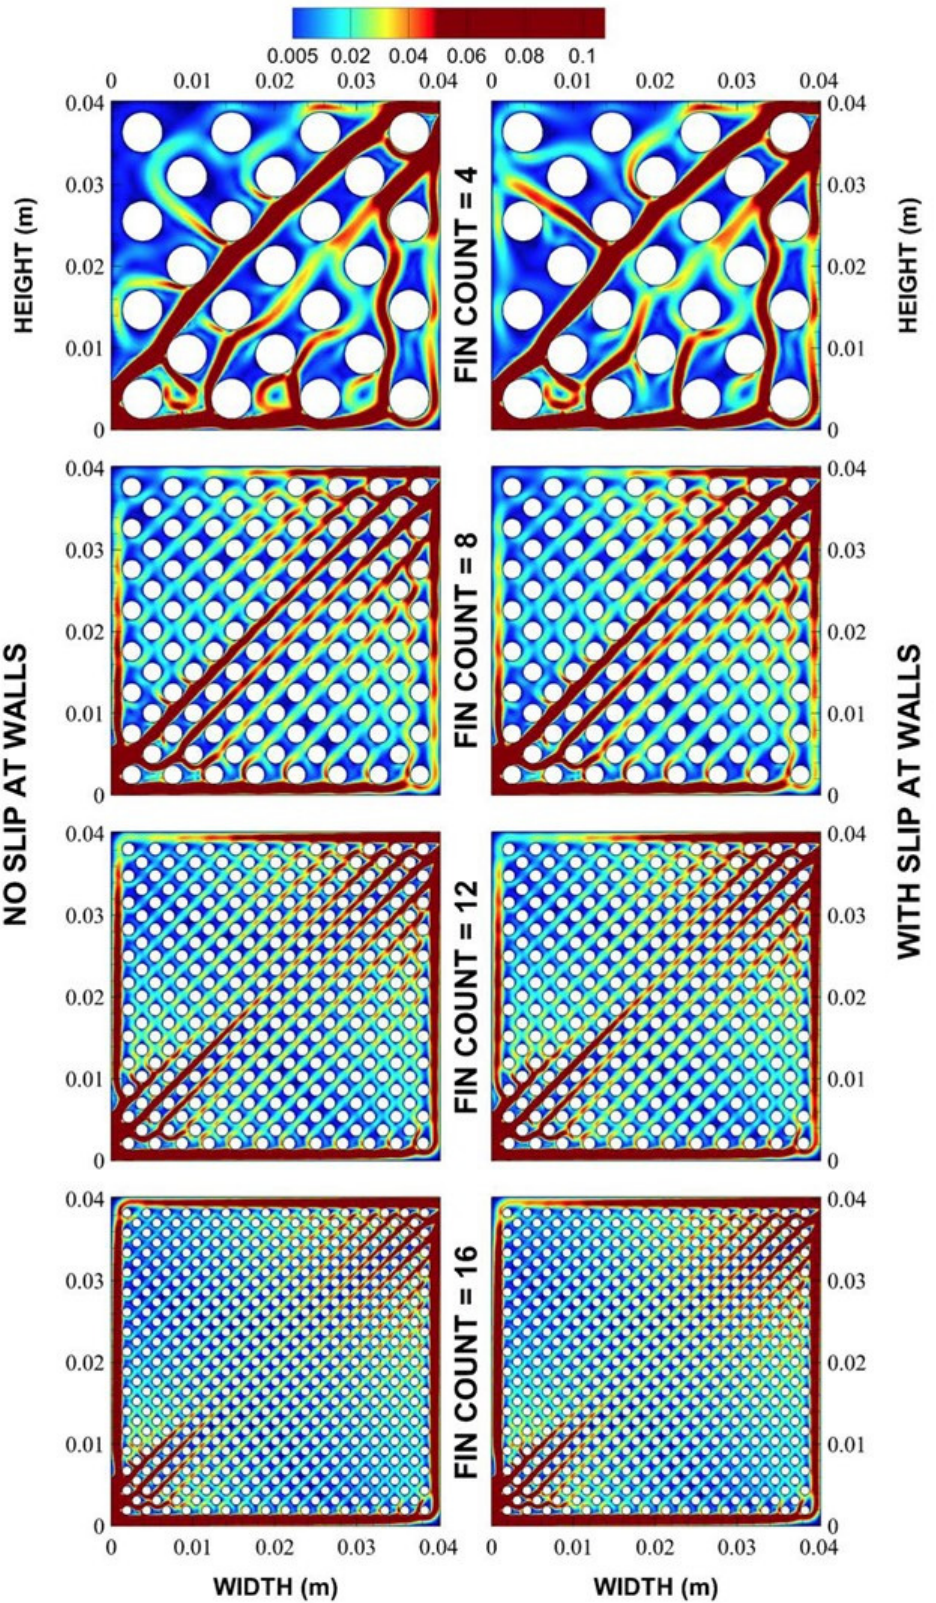
Figure 6. Velocity distribution (m/s) in the solution domain at the midheight of the fin for hydrophobic and hydrophilic fin surfaces for various number of fins and Re = 500.